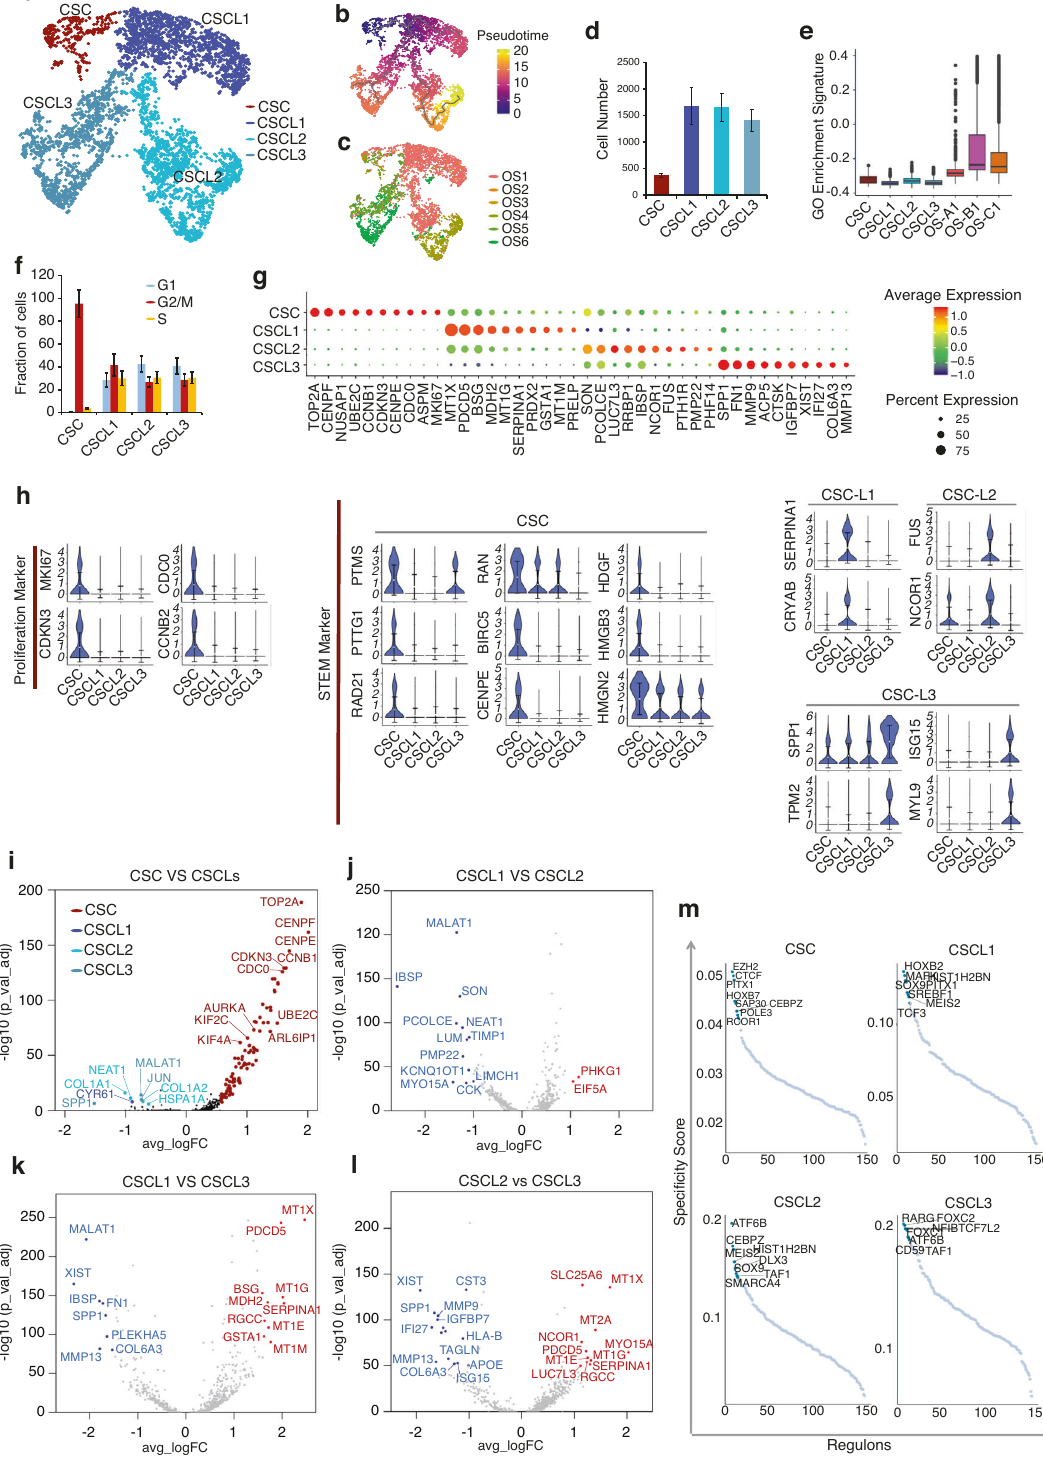
Fig. 6 Molecular features of OS stem cell CSC-like cells. a UMAP plot of CSC-like cells using the Monocle3 method. Four subclusters were identi fi ed in CSC-like cells by graph-based clustering. b Pseudotime trajectory of CSC-like cells. c UMAP plot of CSC-like cells color-coded for each OS sample. d Mean cell numbers of the four subclusters of CSC-like cells in OS samples. e Total GO pathway enrichment among the CSC, CSCL1, CSCL2, CSCL3, and OS-A1/B1/C1 clusters. f The cell proportion of each cell cycle phase in four subclusters of CSC-like cells. g Violin plots showing expression of proliferative markers and stem cell markers in the four subclusters of CSC-like cells. h Dot-plot heatmap of the most signi fi cant genes in the four subclusters of CSC-like cells. i Differences in gene expression between CSCs and other CSC-like subclusters. j Differences in gene expression between CSCL1 and other CSCL2 clusters. k Differences in gene expression between CSCL1 and other CSCL3 clusters. l Differences in gene expression between CSCL2 and other CSCL3 clusters. m TF activity in the four subclusters of CSC-like cells. The top 8 activated TFs are marked in each cluster